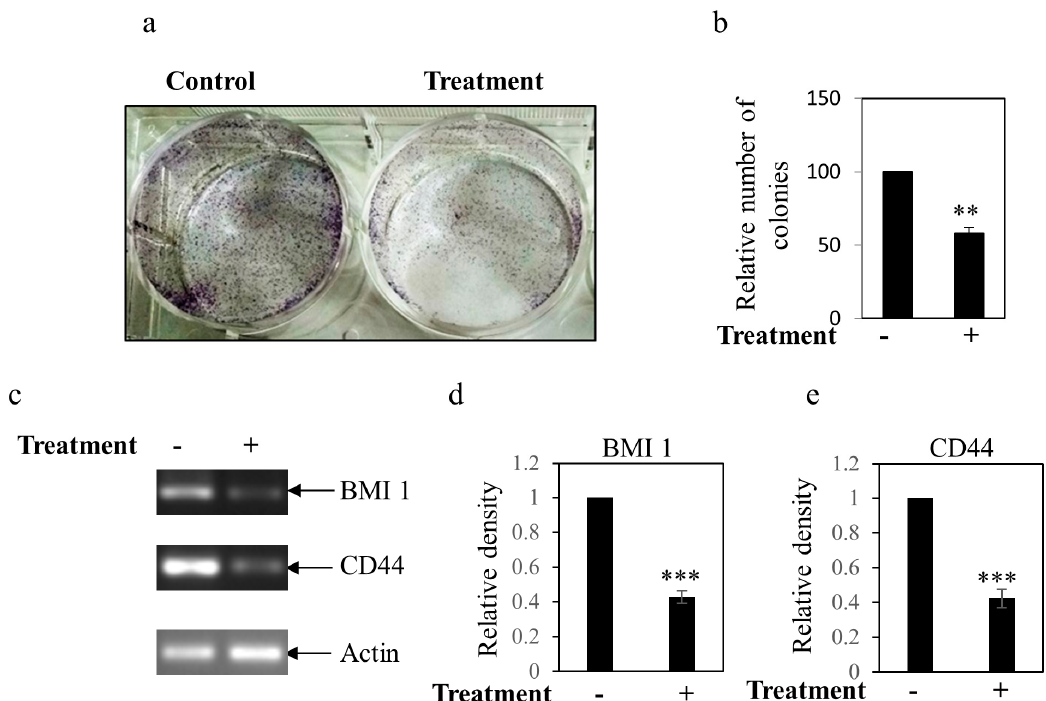
Figure 7. Effect of BEP on the stemness property of breast cancer cell ( a ) Colony formation of MDA-MB-231 cells after a consecutive 5 days of incubation with BEP treatment. Colonies were visualized by inverted bright field microscope. ( b ) Bars represent the number of colony count. Value represents the mean ± SEM of triplicate measurements, ** p < 0.001 vs. control. Treated cells decreased colony formation as compared to control. ( c ) Effect of BEP on the expression of the genes associated with the stemness of breast cancer cells from the total RNA extracted. Bars ( d , e ) showed the densitometry analysis (ratio of concerned gene/Actin) of the bands for BMI1 ( d ) and CD44 ( e ). Value represents mean ± SEM of three replicates. *** p < 0.001 vs. control. Actin was considered as the internal loading control. Transcript levels of cancer stemness-associated genes BMI1 and CD44 were downregulated in response to BEP.